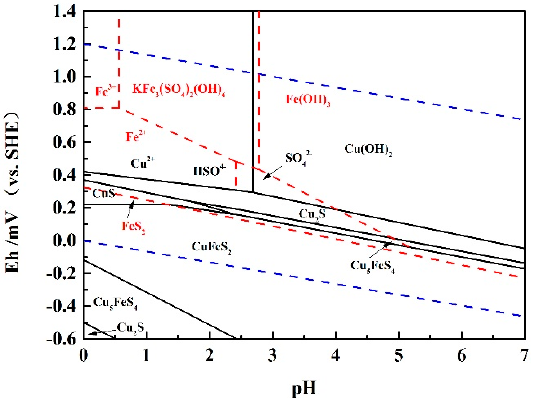
Figure 8. Pourbaix diagram of chalcopyrite (black solid line) and pyrite (red dashed line). (SHE stands for standard hydrogen electrode)